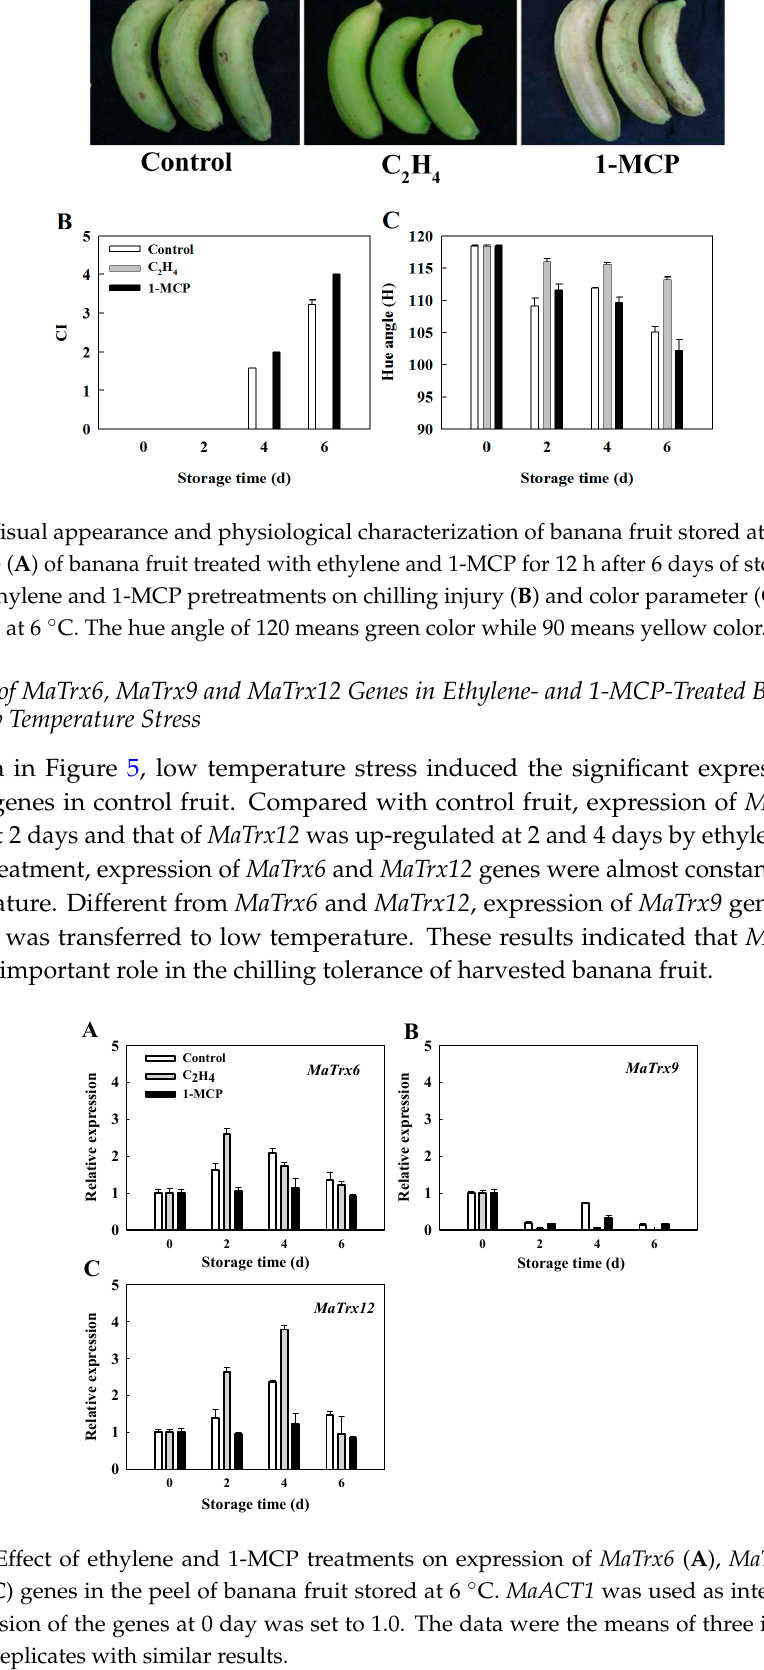
Figure 5. Effect of ethylene and 1-MCP treatments on expression of MaTrx6 ( A ), MaTrx9 ( B ) and MaTrx12 ( C ) genes in the peel of banana fruit stored at 6 °C. MaACT1 was used as internal control. The expression of the genes at 0 day was set to 1.0. The data were the means of three independent biological replicates with similar results.